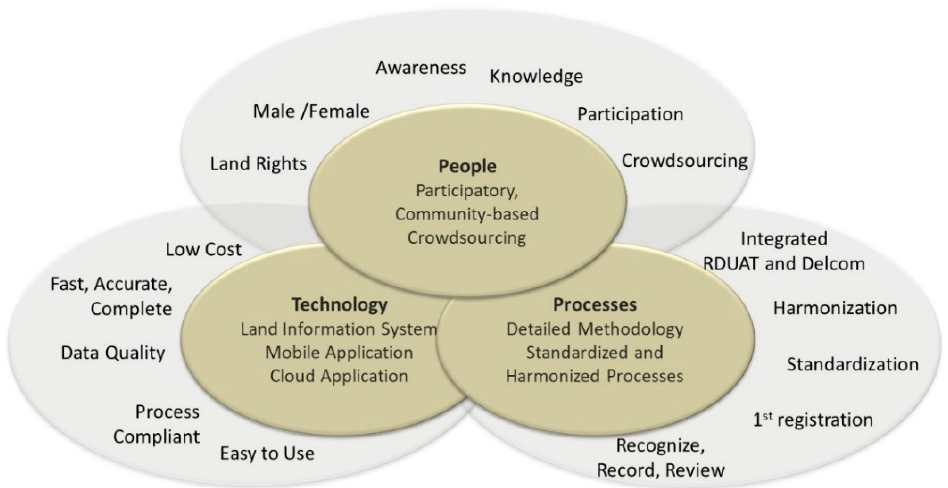
Figure 2. The Conceptual Model for developing the FFPLA-MOZ approach based on three inter- twined pillars: People, Processes and Technology.